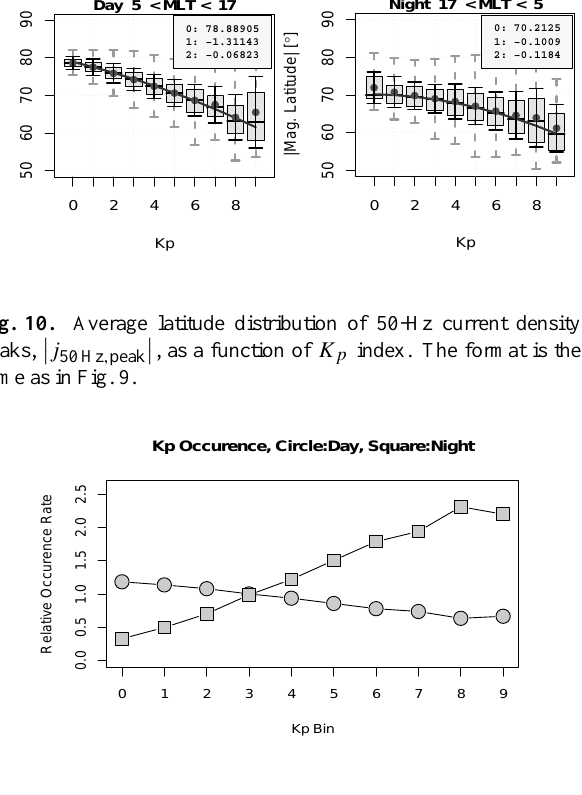
Fig. 11. Day and night occurrence frequencies of events in our table with respect to the all-day K p